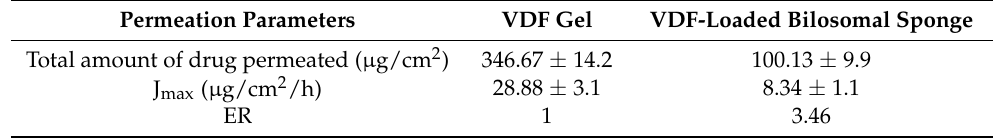
Table 3. Ex vivo permeation of VDF gel and VDF-loaded bilosomal formulation from sheep buccal mucosa. Permeation